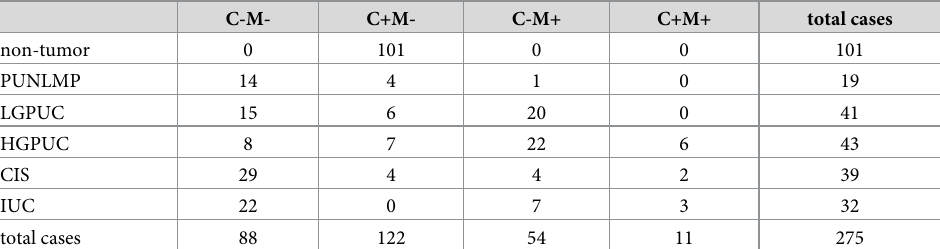
Table 2. Subcellular immunolocalization of Spred2 in each tumor category.